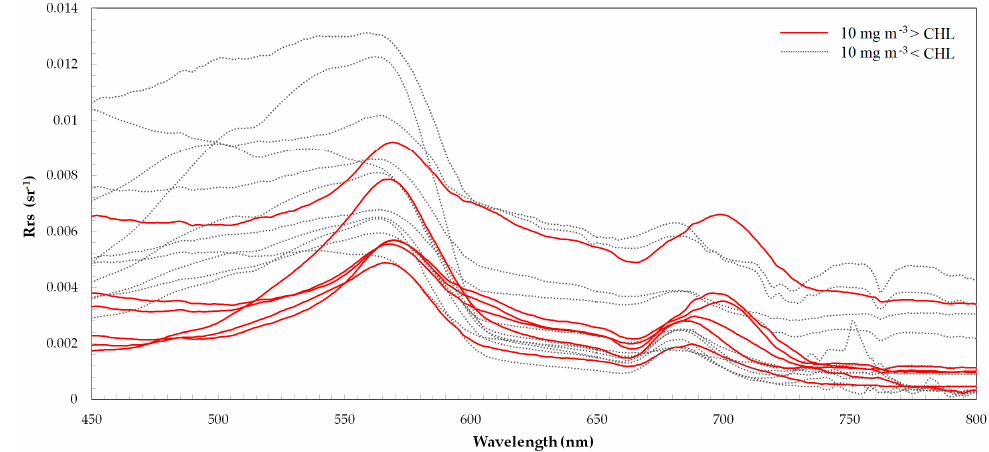
Figure 2. In situ R rs spectra at all sampling locations. The spectra of samples with 10 mg m − 3 or greater CHL show a distinct reverse triangle pattern in the green and red wavelengths.